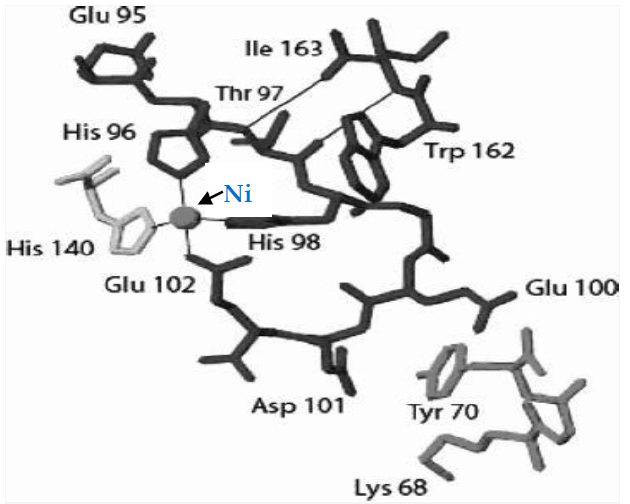
Scheme 1. The structure of NiARD with Tyr residue in the outer coordination sphere of a nickel ion